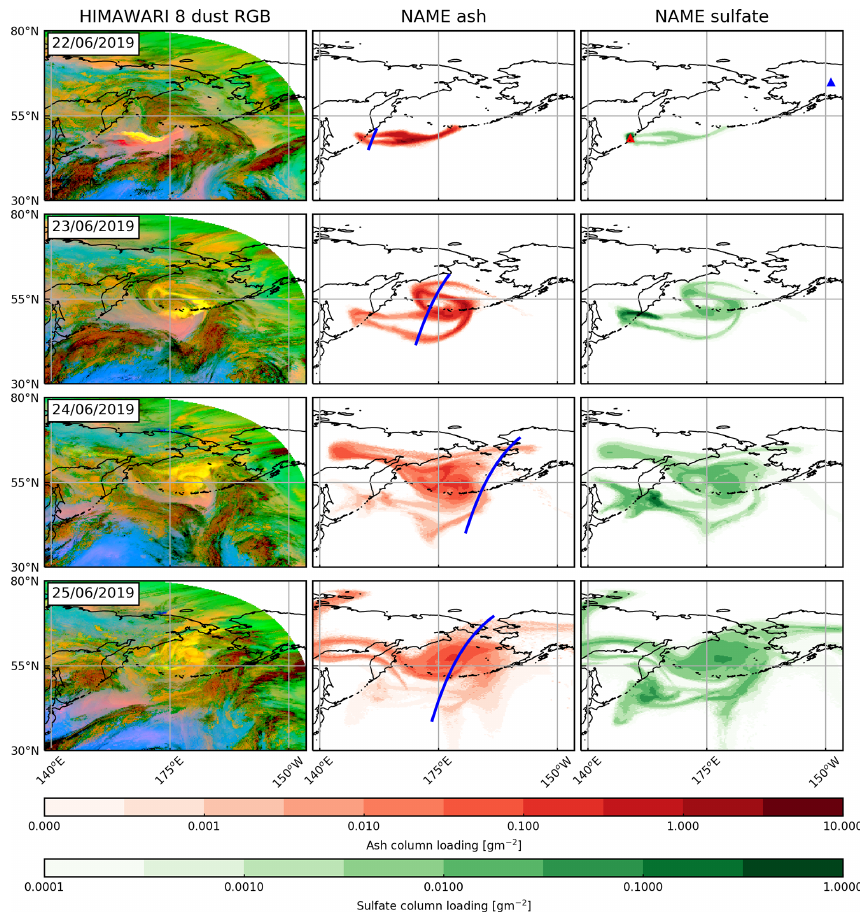
Figure 3. Column one: Himawari-8 dust RGB for dates shown; columns two and three: NAME simulated column loadings for ash and sulfate clouds [gm − 2 ]. Both the Himawari data and the NAME simulation data are for 15:00UTC on the date shown. The red and blue triangles in the upper-right panel show the locations of the Raikoke volcano and the Fairbanks MPLNET lidar respectively. The blue line in the central column shows the CALIPSO track at that